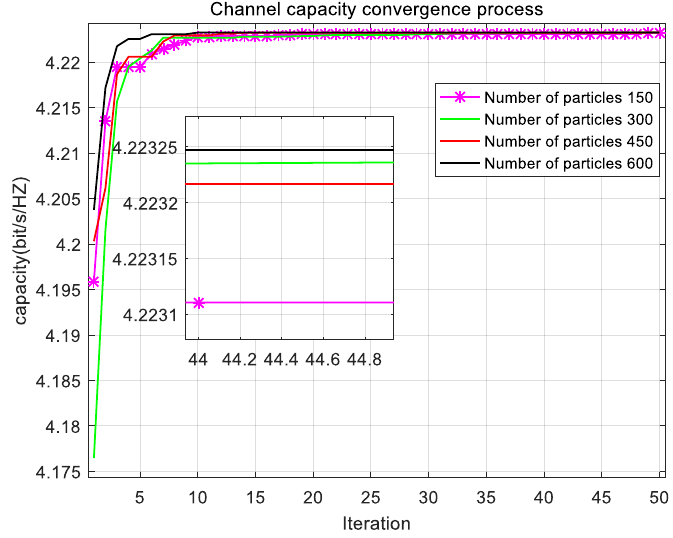
Figure 5. Comparison of channel capacity for different population sizes.